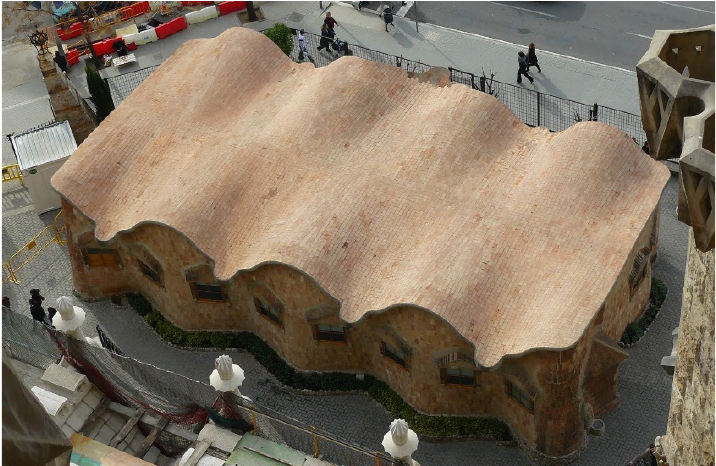
Figure 18. The Sagrada Familia Schools re ‐ built. A. Gaudi.